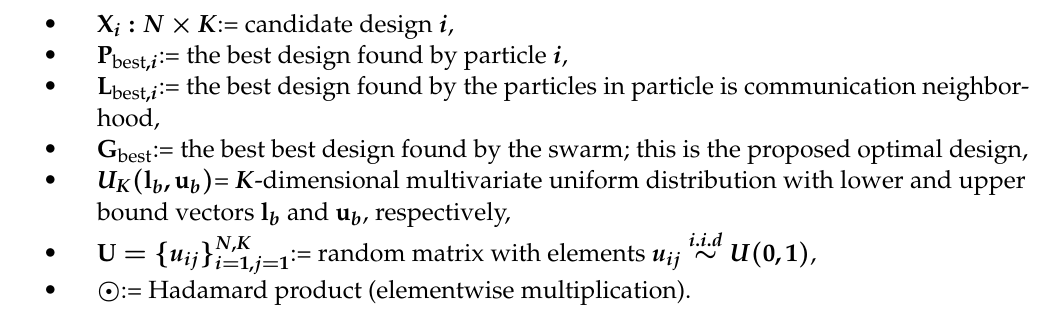
Algorithm 1: PSO for Generating Exact Optimal Designs on the